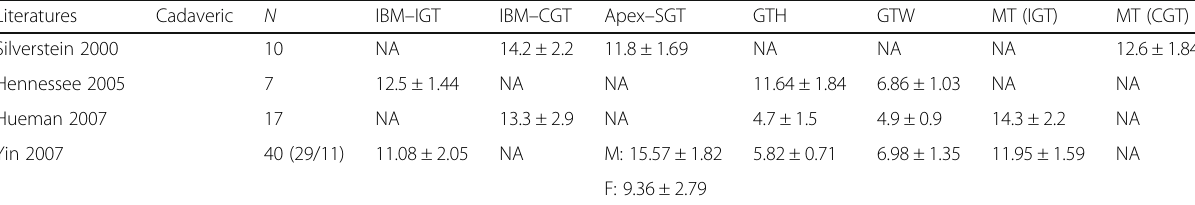
Table 2 Comparison of the measurements for the genial tubercle position evaluated from cadavers Literatures